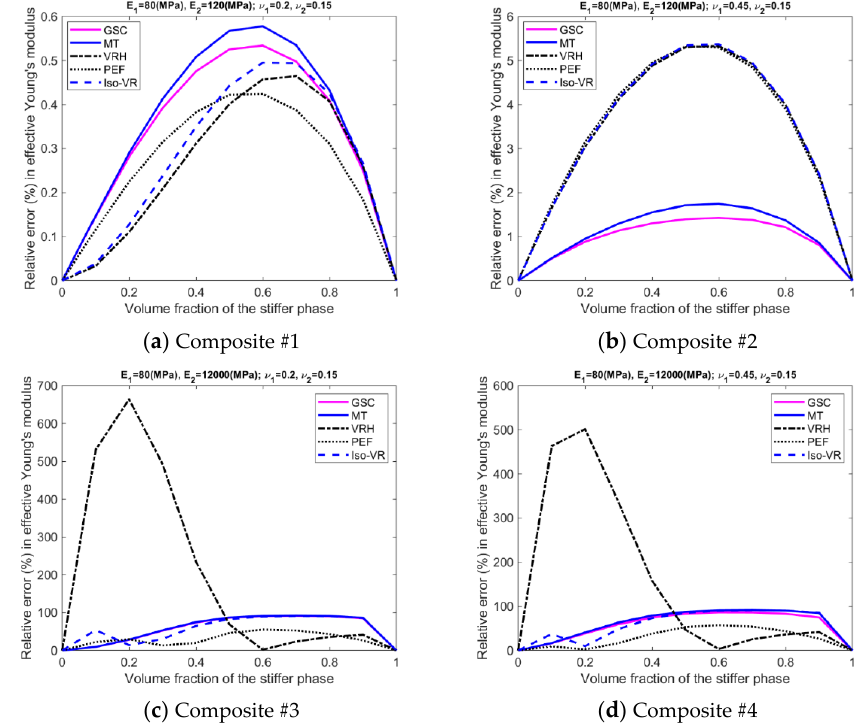
Figure A4. Composite #4—large contrast in both phase Young’s modulus and phase Poisson’s ratio. ( a ) Young’s modulus; ( b ) shear modulus; ( c ) bulk modulus; ( d ) Poisson’s ratio. Figures A5–A8 show relative errors measured by Equation (13), in the effective Young’s modulus, shear modulus, bulk modulus, and Poisson’s ratio.